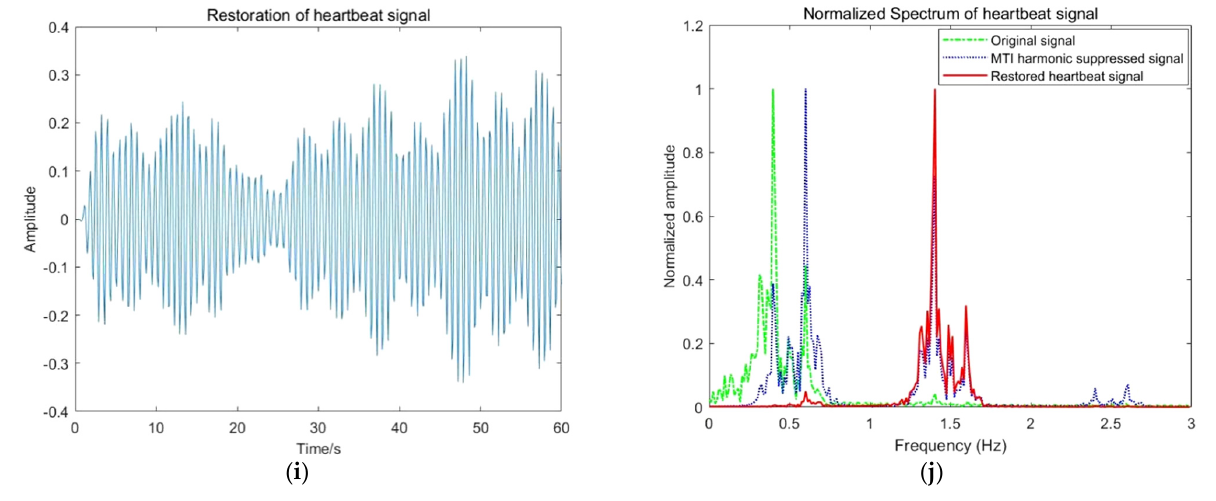
Figure 28. Results of essential steps for experiment group 5: ( a ) Radar raw data; ( b ) Radar data after preprocessing; ( c ) The relative principal component; ( d ) Spatial eigenvector; ( e ) Temporal eigenvector; ( f ) Energy entropy; ( g ) Restoration of respiratory signal; ( h ) Respiratory signal spectrum; ( i ) Restoration of heartbeat signal; ( j ) Heartbeat signal spectrum.